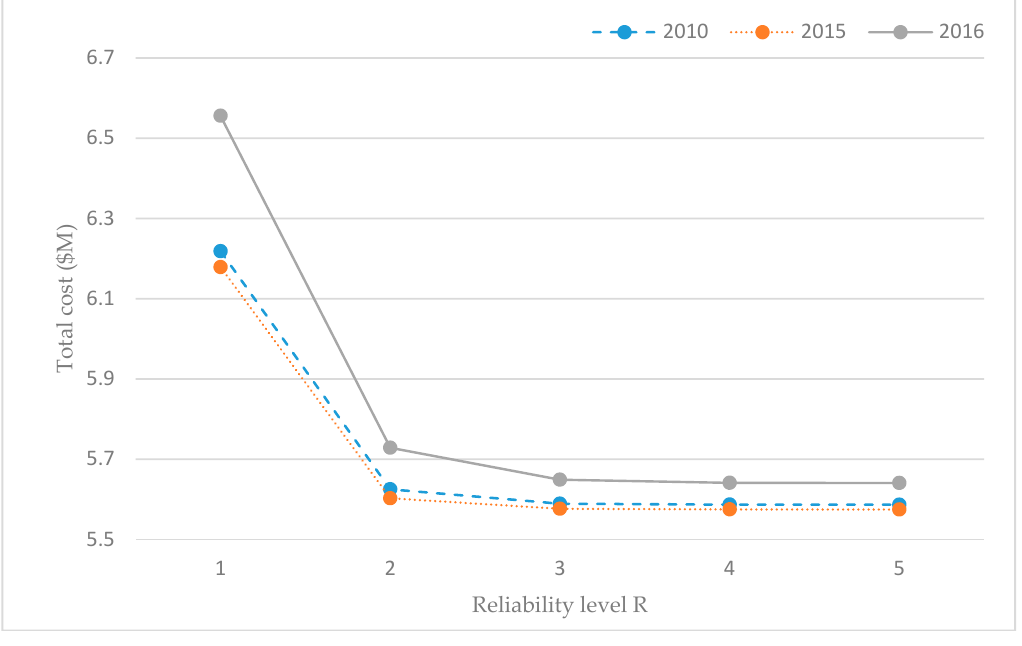
Figure 10. Cost with different failure probability.